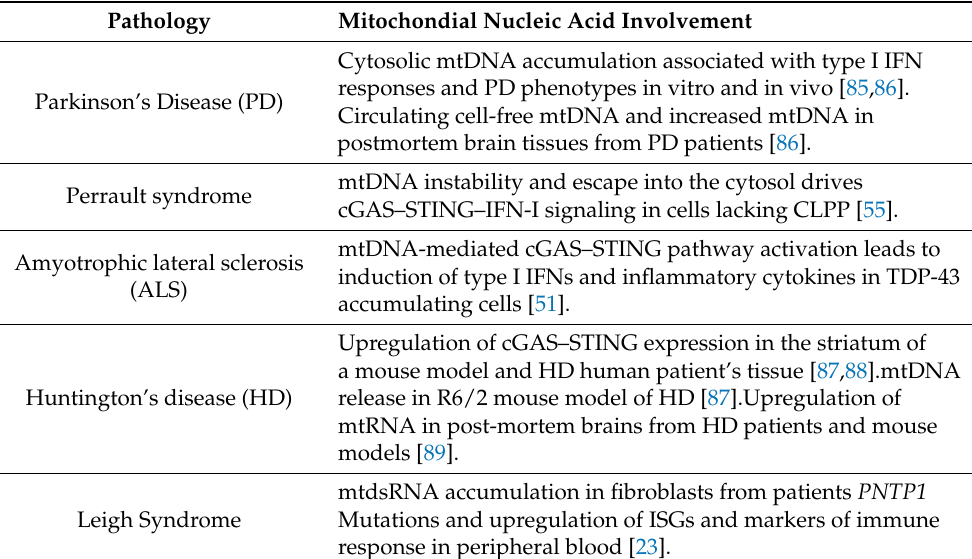
Table 1. Role of mtDNA and mtRNA in neurodegenerative